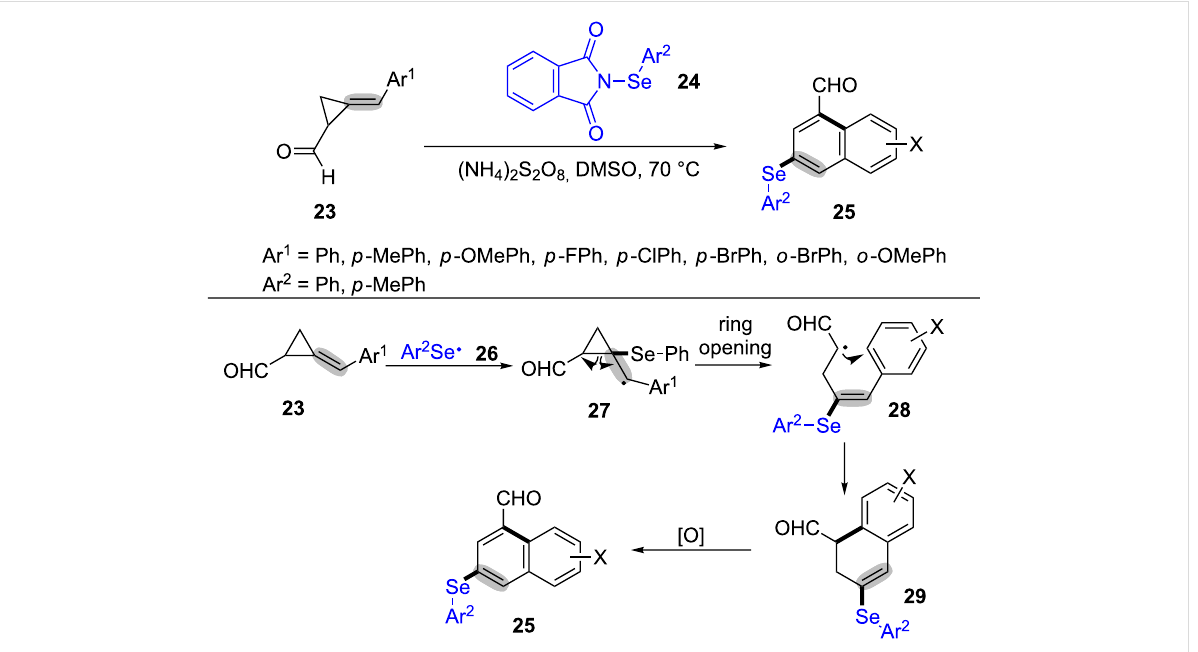
Scheme 8: Organic-selenium induced radical ring-opening and cyclization of MCPs derivatives (cyclopropylaldehydes).